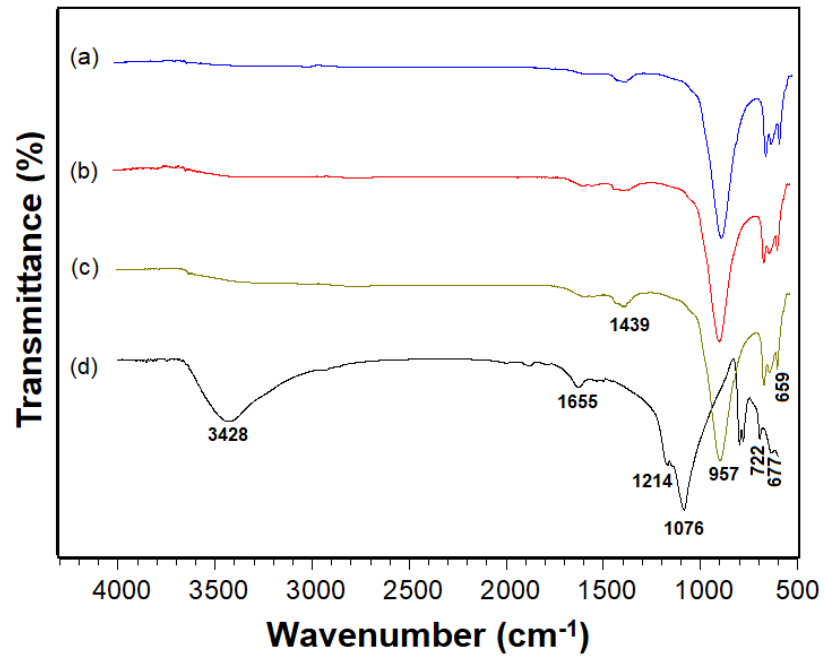
Figure 5. FTIR of the geopolymer filled with 3% ( a ), 2% ( b ), and 1% ( c ) of magnetite and magnetite nanoparticles ( d